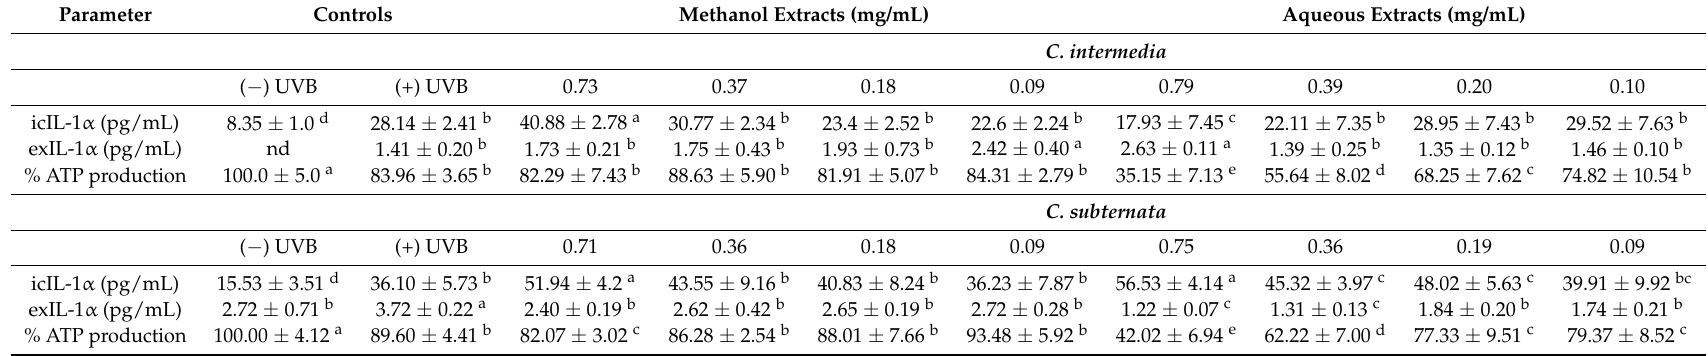
Table 4. Modulation of IL-1 α and accumulation by the different honeybush extracts in relation to their effect on cell viability (ATP content).